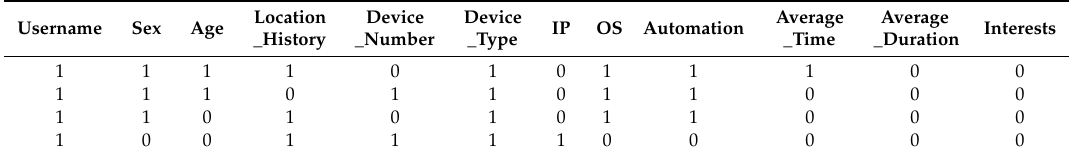
Table 1. Parameters